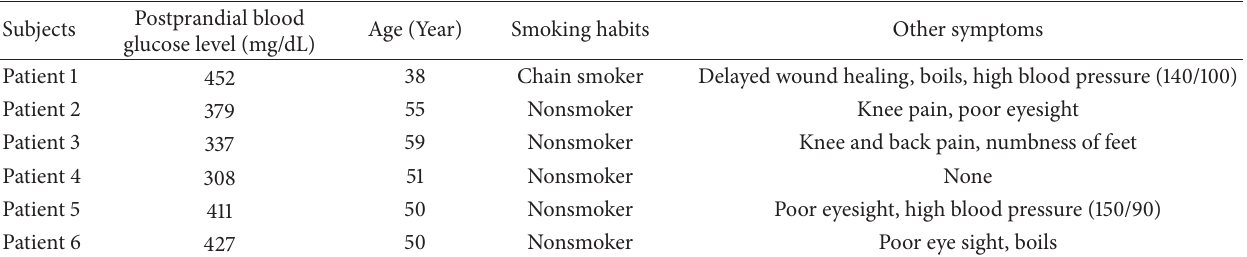
Table 1: Clinical characteristics of studied subjects.